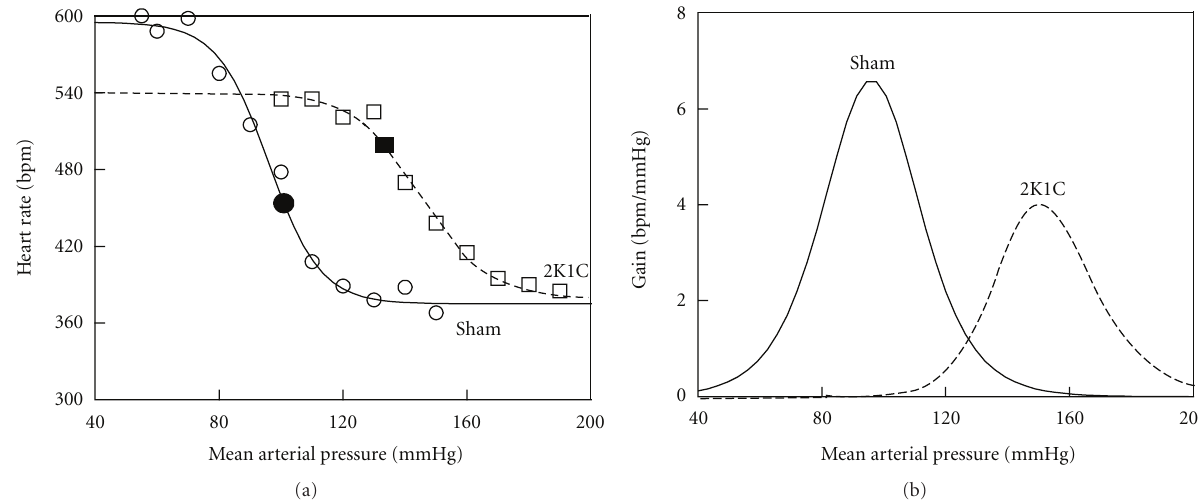
Figure 4: Plots showing typical reflex heart rate changes as a function of drug-induced changes in arterial pressure using logistic, sigmoidal- fitting barocurve analysis (a) and baroreflex gains calculated from the first derivative of the sigmoid function (b) comparing 2K1C with sham mice. The small circles and squares indicate individual changes in heart rate in response to every 10 mmHg of drug-induced changes in arterial